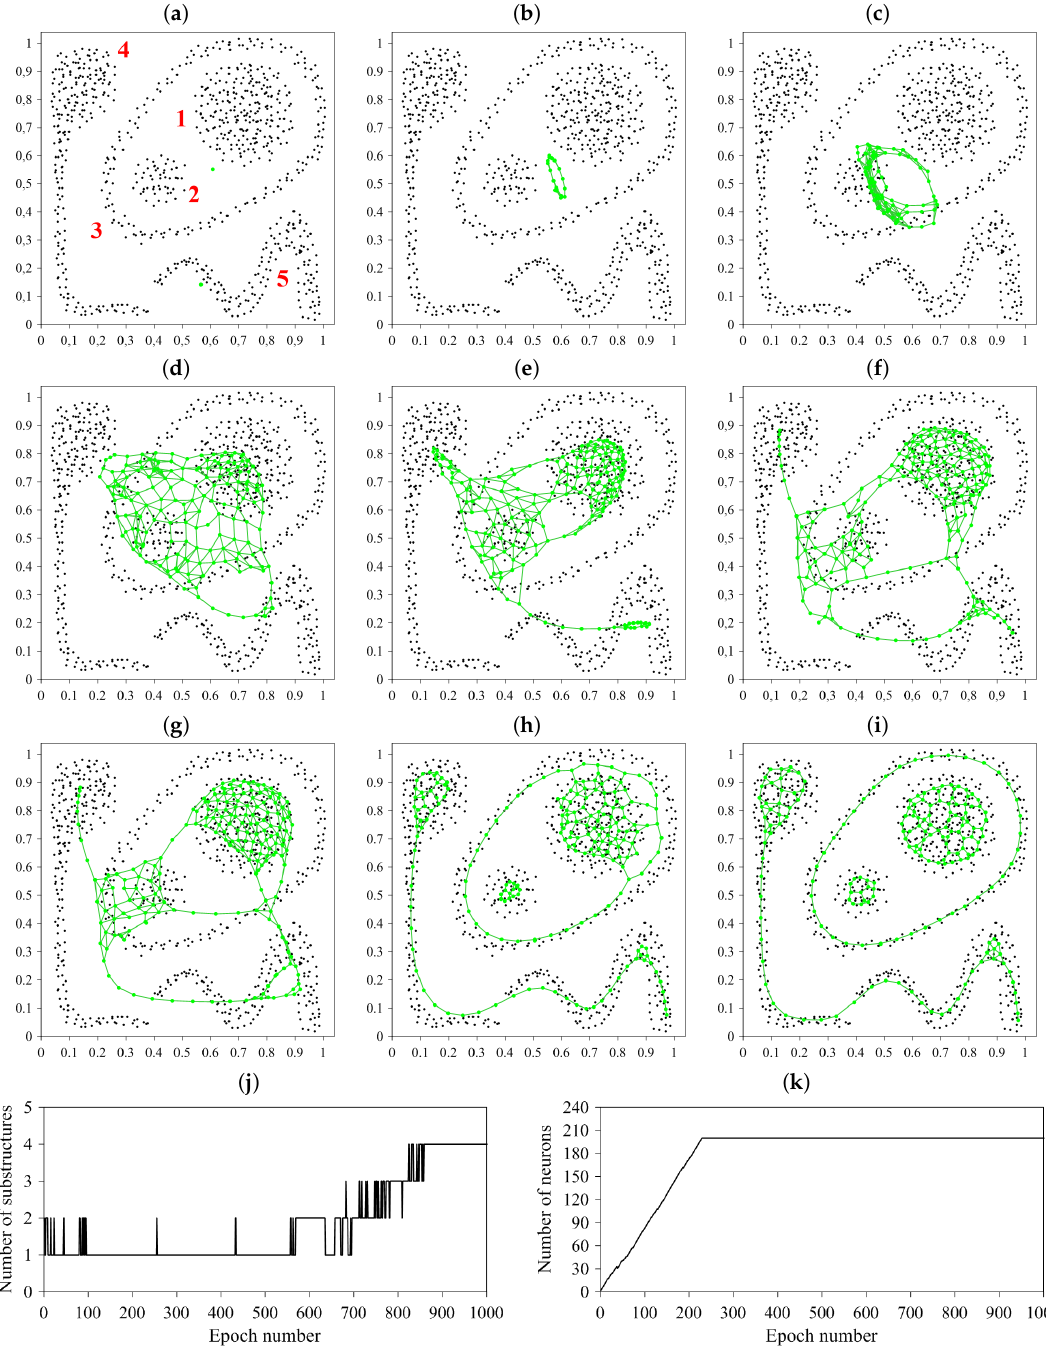
Figure 14. The evolution of Growing Neural Gas (GNG) in the synthetic data set of Figure 6a in learning epochs: ( a ) No. 0 (start of learning), ( b ) No. 5, ( c ) No. 10, ( d ) No. 20, ( e ) No. 30, ( f ) No. 50, ( g ) No. 100, ( h ) No. 800, and ( i ) No. 1000 (end of learning) as well as plots of the number of substructures ( j ) and the number of neurons ( k ) vs. epoch